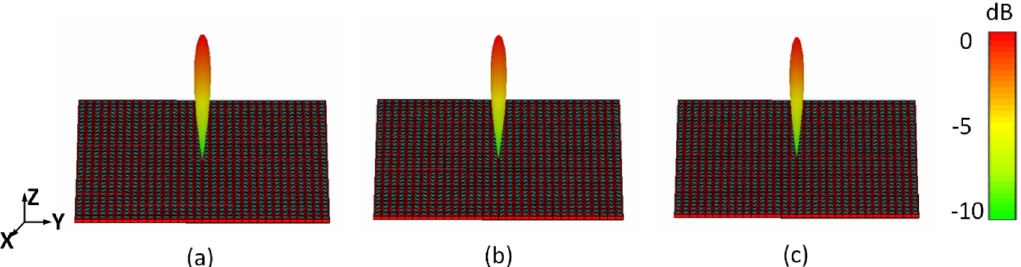
Fig. 6. Normalized E-pattern of Metasurface I at (a) 1.30 THz, (b) 1.50 THz, (c) 1.70 THz when the chemical potential is 0eV.